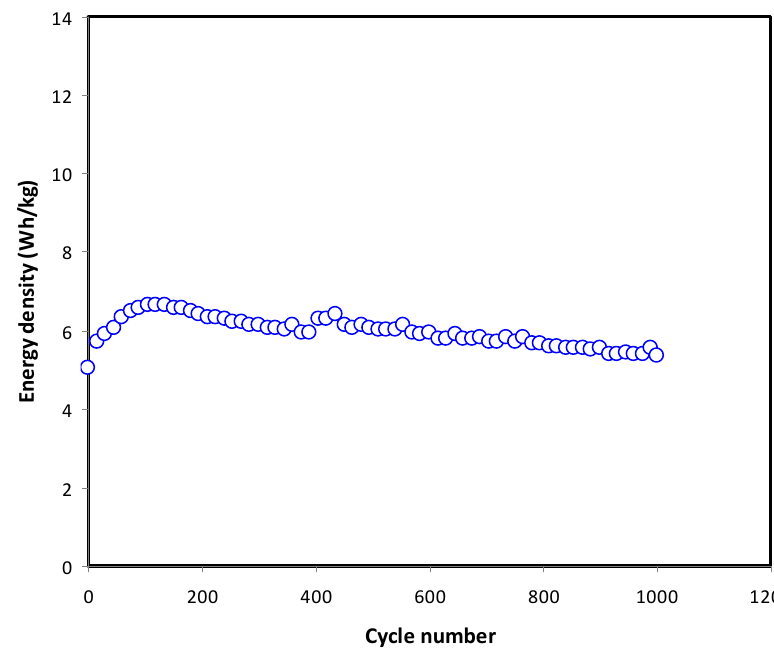
Figure 12. The plot of energy ( E ) of the fabricated EDLC throughout 1000 cycles.